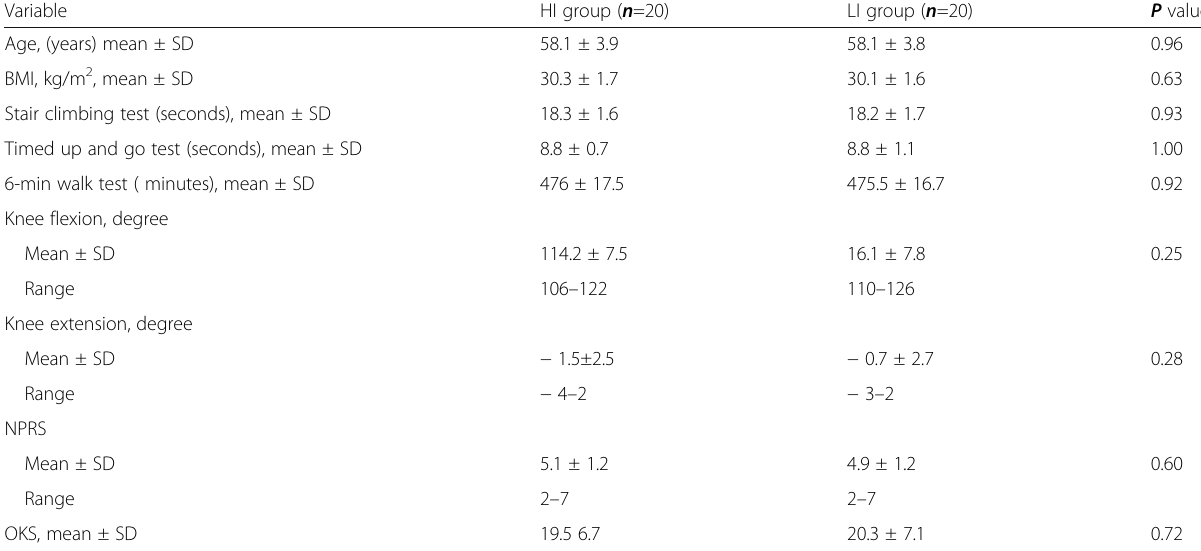
Table 1 Preoperative characteristics of both groups